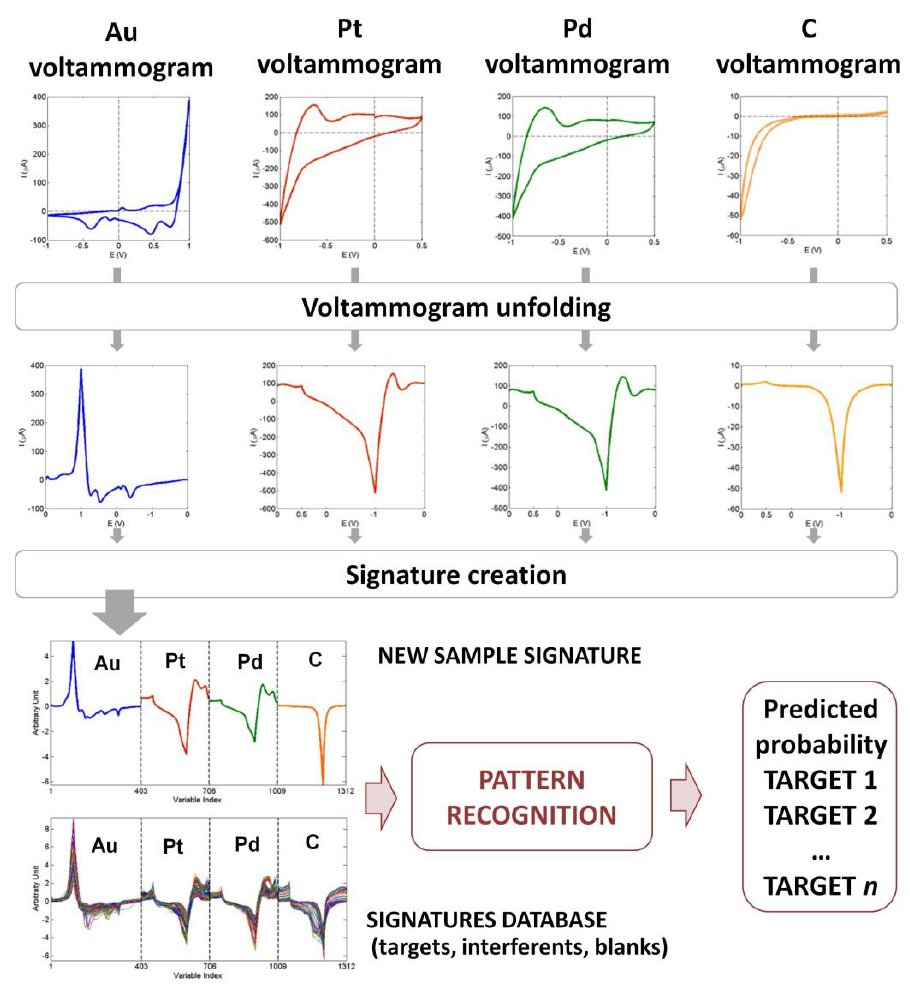
Figure 3. Electrochemical data analysis approach.